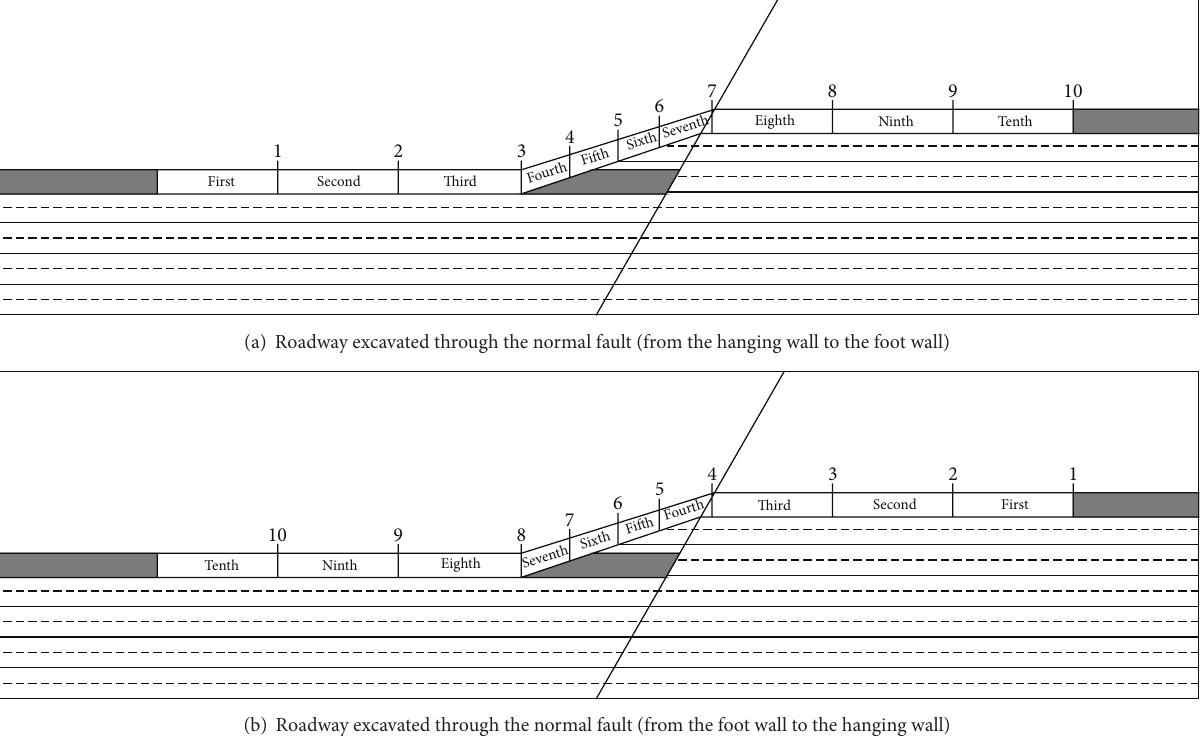
Figure 8: Simulated roadway excavation process and the layout of observation stations. Note: first to tenth denotes the excavation sequence; one to ten denotes the observation